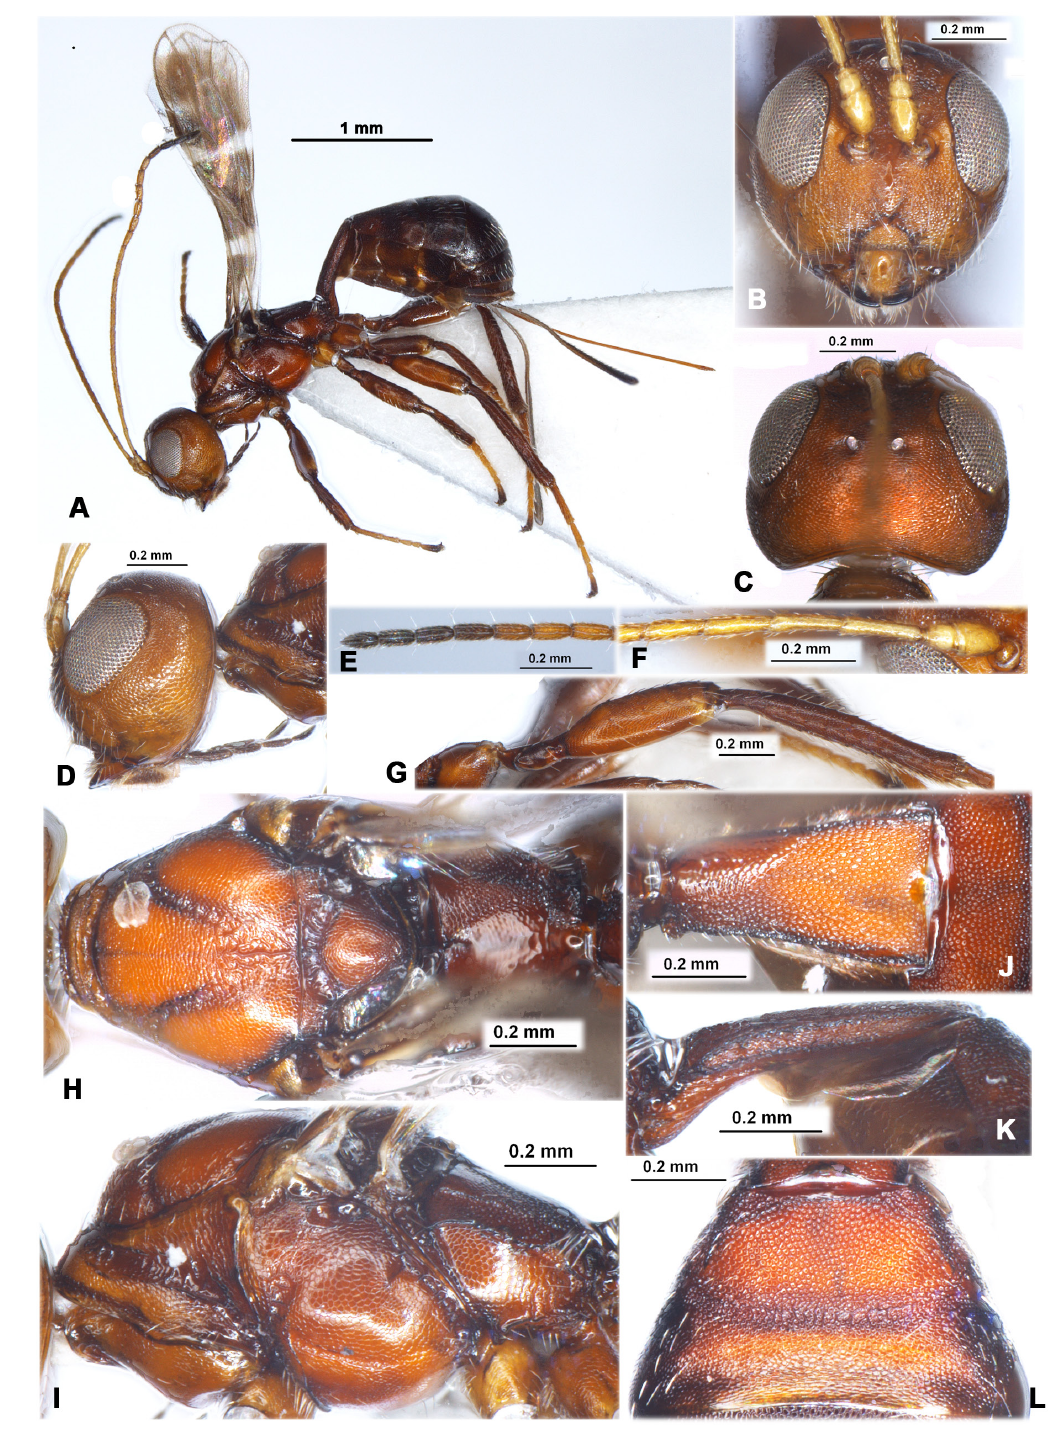
Fig. 39. Platyspathius ( P. ) brevis Belokobylskij sp. nov., holotype, ♀ (RMNH). A . Habitus, lateral view. B . Head, front view. C . Head, dorsal view. D . Head, lateral view. E . Apical segments of antenna. F . Basal segments of antenna. G . Hind leg. H . Mesosoma, dorsal view. I . Mesosoma, lateral view. J . First metasomal tergite, dorsal view. K . First metasomal tergite, lateral view. L . Second and third metasomal tergites, dorsal